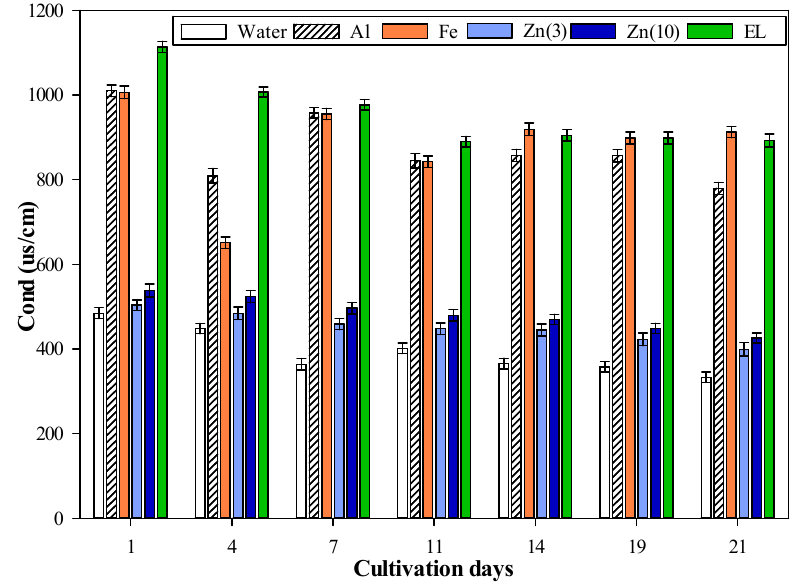
Figure 4. Variations in mean (±S.D.) conductivity of the water in the different treatments.